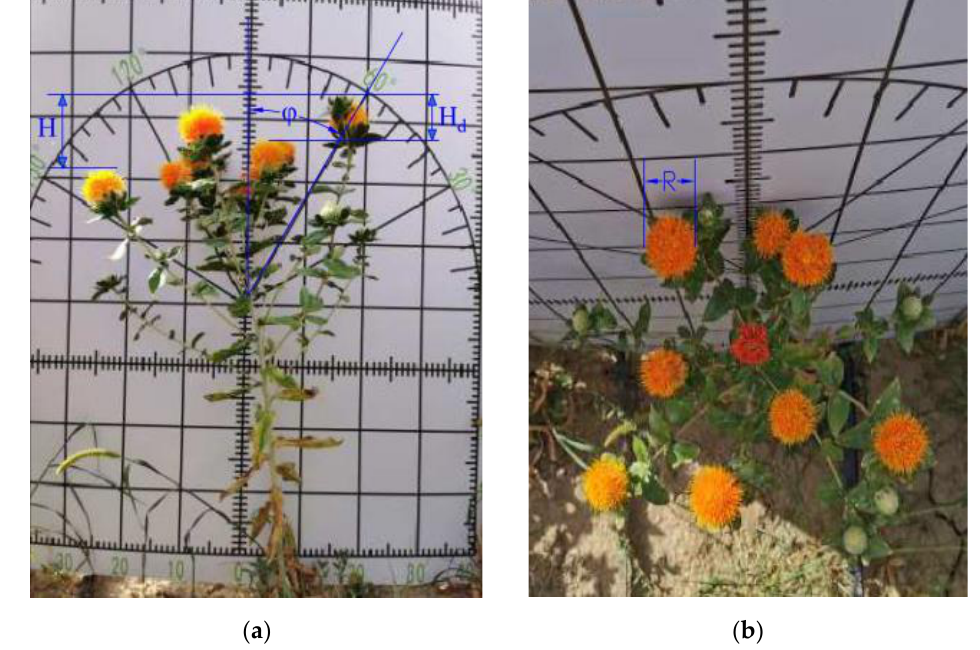
Figure 3. Morphological map of safflower plants: ( a ) Main view; ( b ) Vertical view.